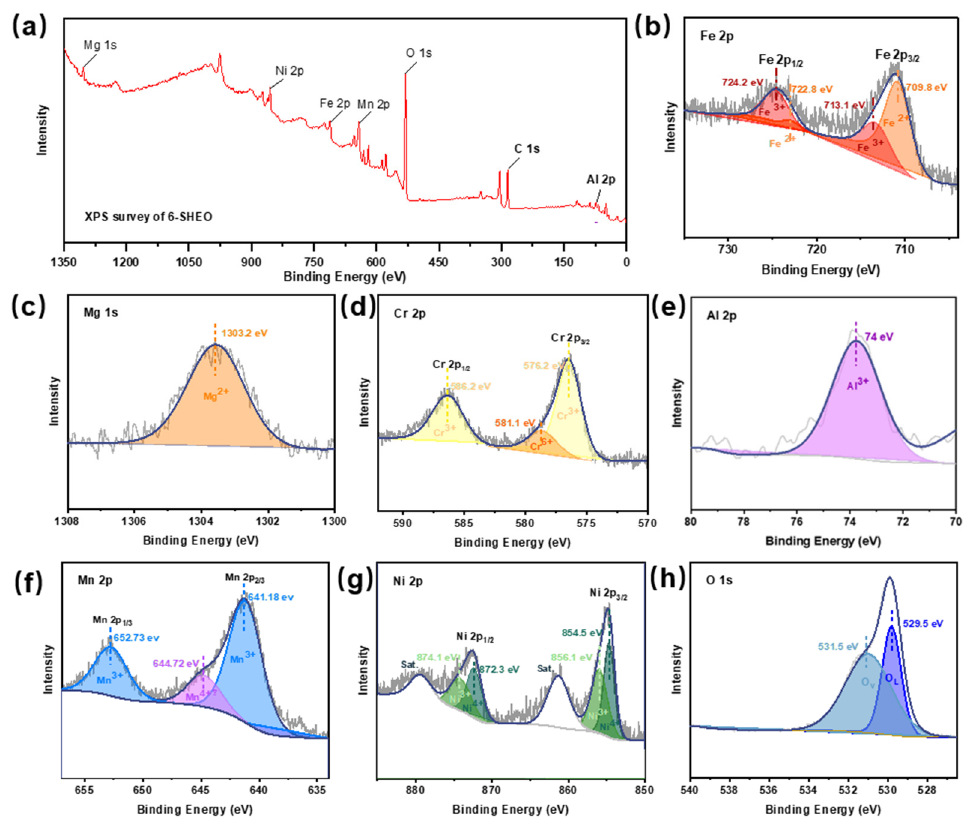
Figure 3. High-resolution XPS spectra of the 6-SHEO. ( a ) Survey spectrum, ( b ) Fe 2p, ( c ) Mg 1s, ( d ) Cr 2p, ( e ) Al 2p, ( f ) Mn 2p, ( g ) Ni 2p, and ( h ) O 1s. 2p, ( e ) Al 2p, ( f ) Mn 2p, ( g ) Ni 2p, and ( h ) O